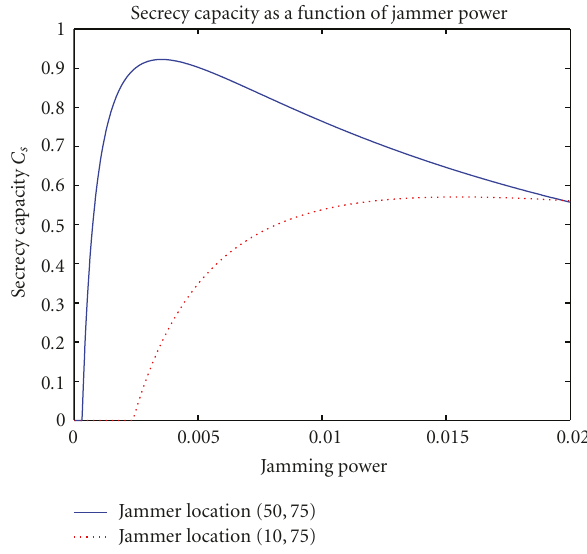
Figure 1: System model for the proposed physical layer security game.